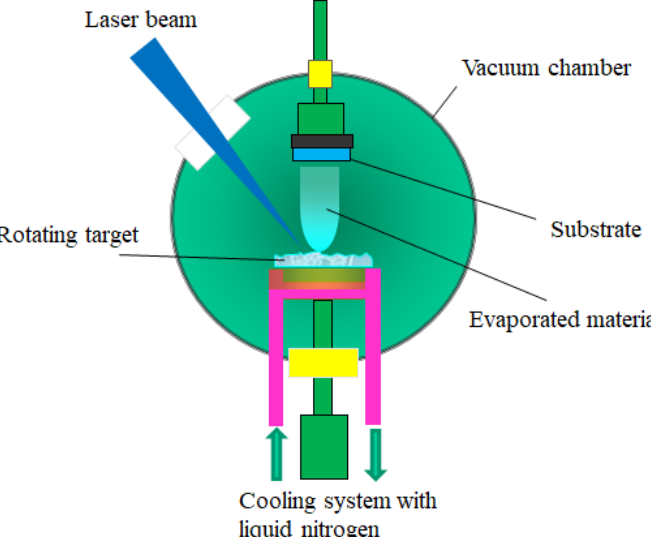
Figure 8. The schematic setup of the MAPLE technique. Adapted from reference [86].